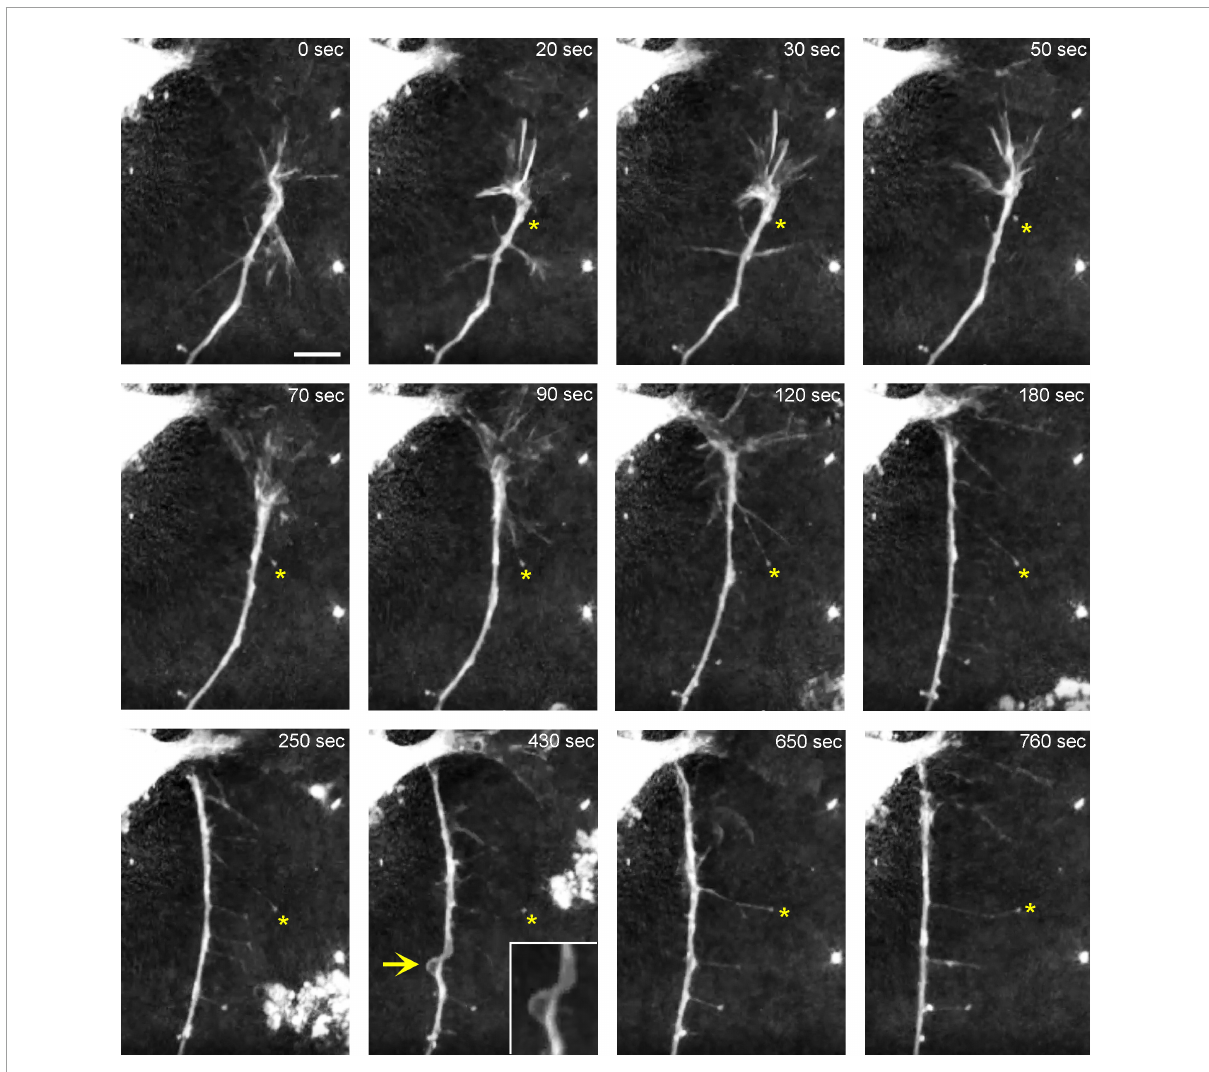
FIGURE7 The dynamics of a growth-cone region in a primary midbrain culture (monolayer at DIV 1), visualized with time-lapse holotomography ( Supplementary Video 2 ). As the growth cone finds its next attachment target and pulls the axon to the left, its adhesion sites are revealed (one such site is marked with an asterisk). The spacing between the adhesion sites is around 2–6 µ m, and the nanoscale tethers connecting them to the main axon can be stretched to as long as 10 µ m (to accommodate axon shifts). This spatial configuration closely resembles that shown in Figure 3 . The arrow points to an axon segment that appears flat and twisted in a corkscrew-like fashion. To emphasize key transitions, time points are not evenly spaced. This imaging supports the interpretation of the dynamics that may underly the confocal microscopy data, but the recorded axons are not labeled and may not be serotonergic. Scale bar = 5 µ